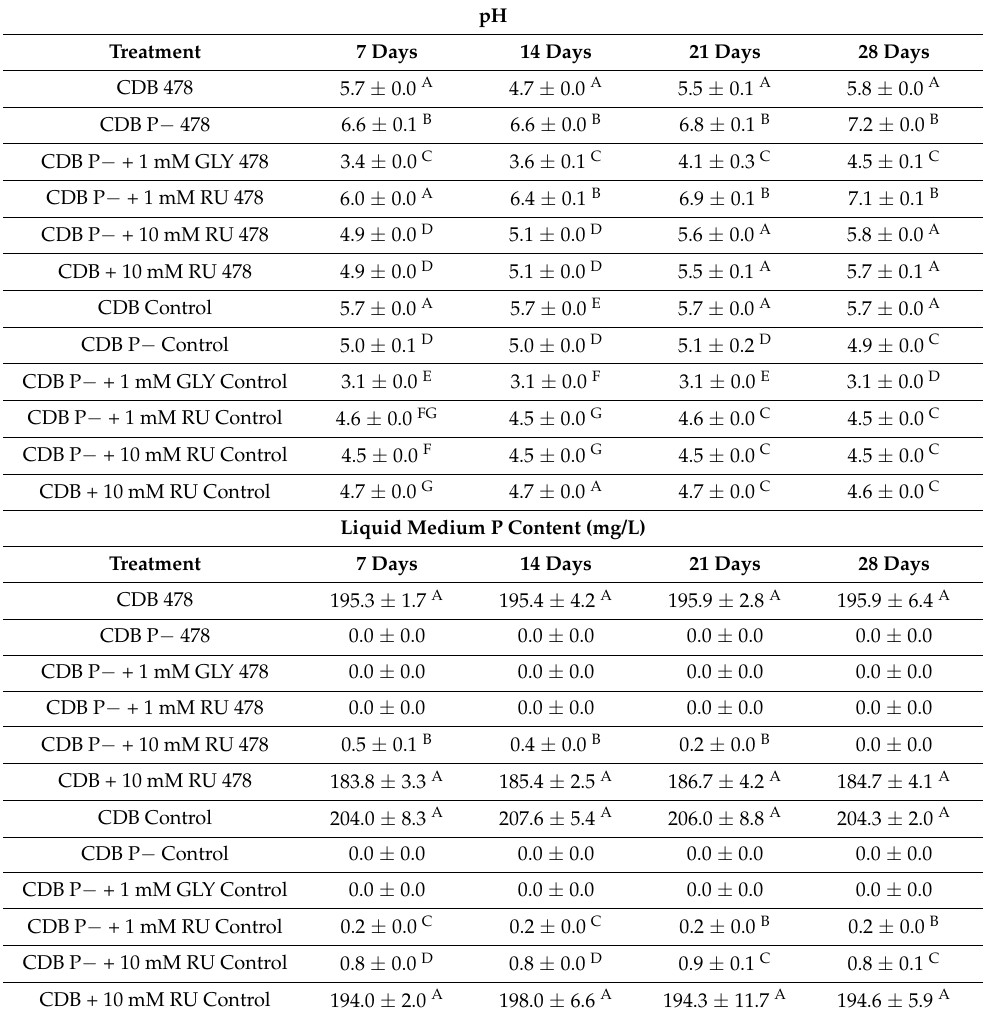
a The same superscript letters denote no significant difference between values within the same timepoint column (post hoc Dunnet T3 test or Conover test, p >